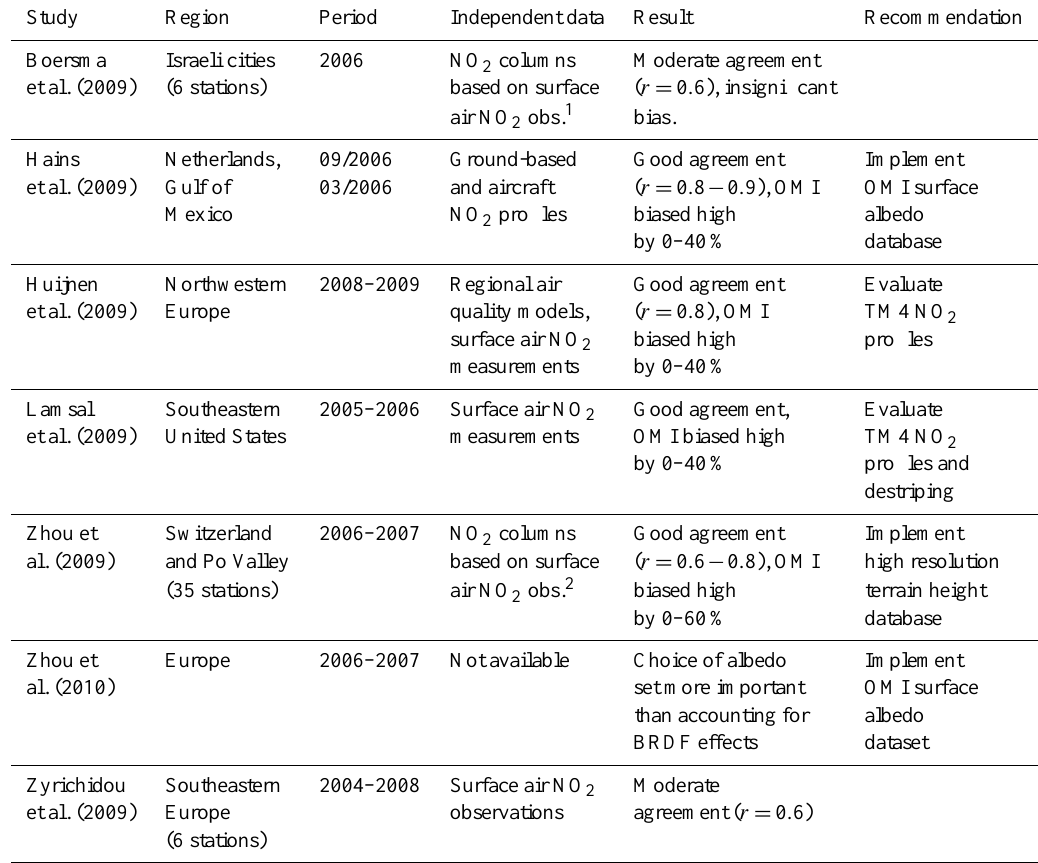
Table 1. Summary of validation studies with DOMINO v1.02 tropospheric NO 2